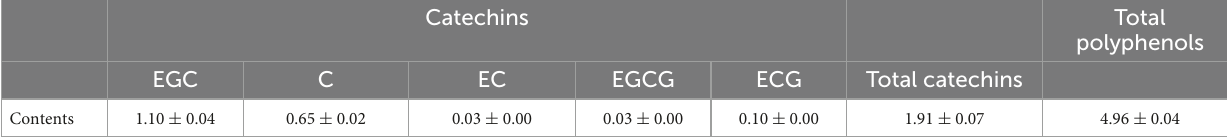
TABLE 2 Catechins content in CHI leaves infusion (1/10, m/v; mg/mL) a .